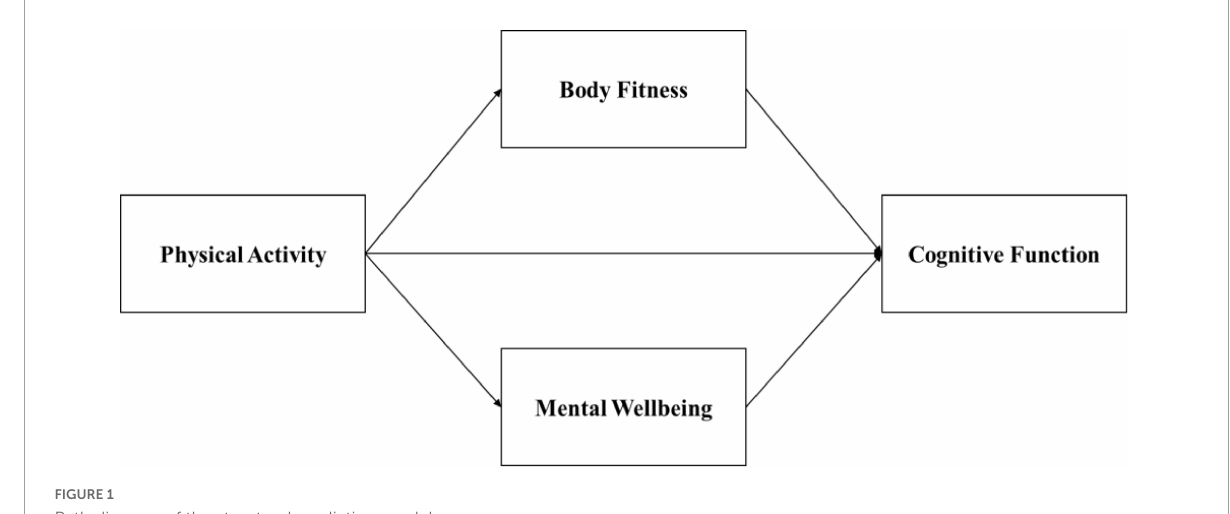
FIGURE1 Path diagram of the structural mediation model.